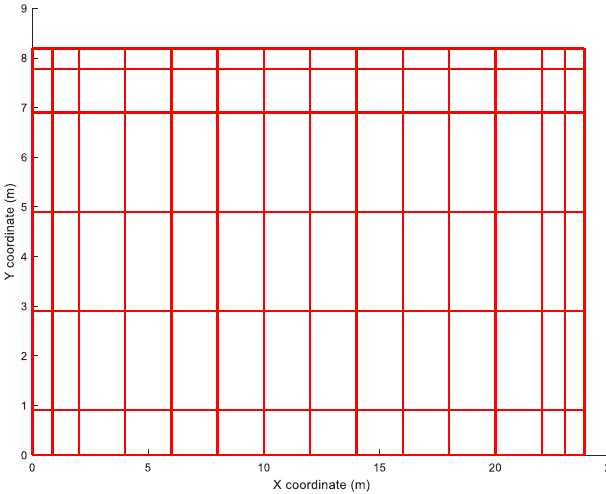
Figure 3. Representation in the XY plane of the grounding electrode of the Balaidos high-voltage substation (Spain).